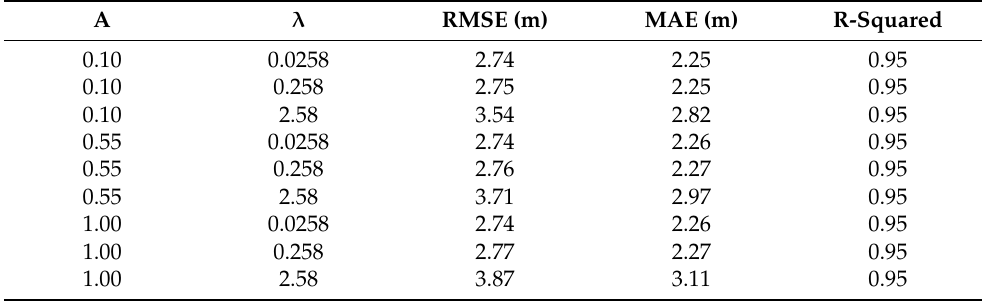
Table 3. The top performing elastic nets with their optimally tuned parameters and corresponding error